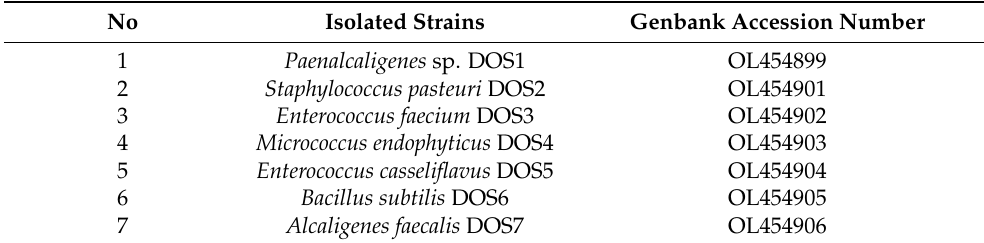
Table 1. Genbank accession numbers of isolated